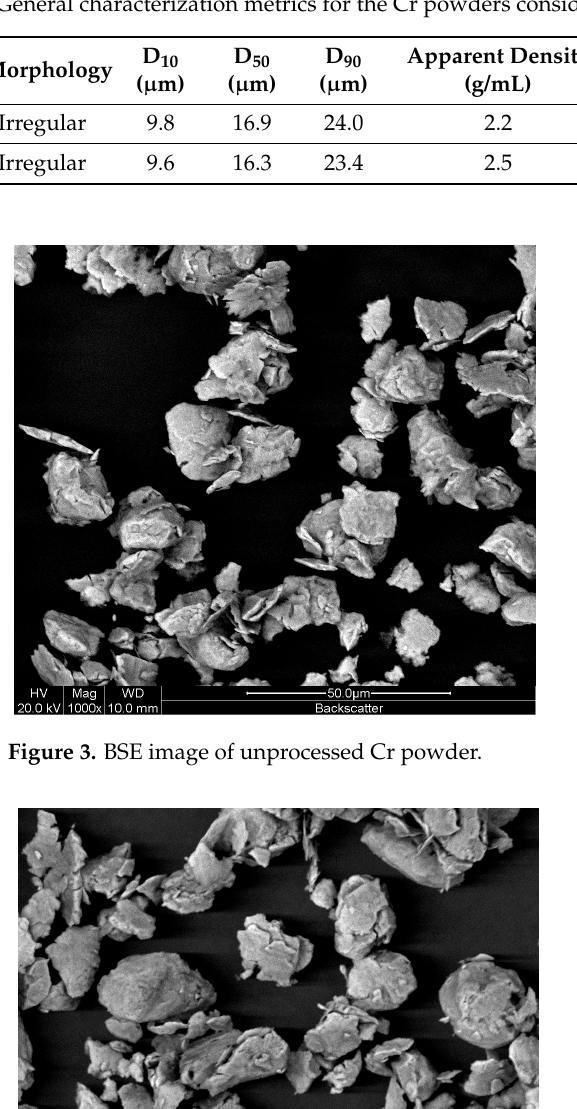
Table 3. The dried chromium was dried at 60 °C for 24 h. Example SEM micrographs for